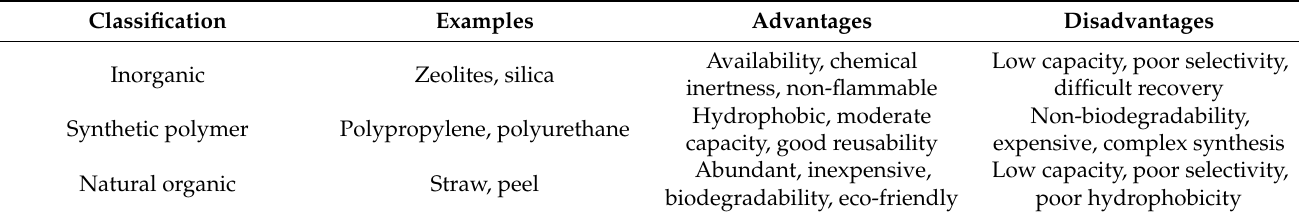
Table 1. Advantages and disadvantages of three types of sorbent